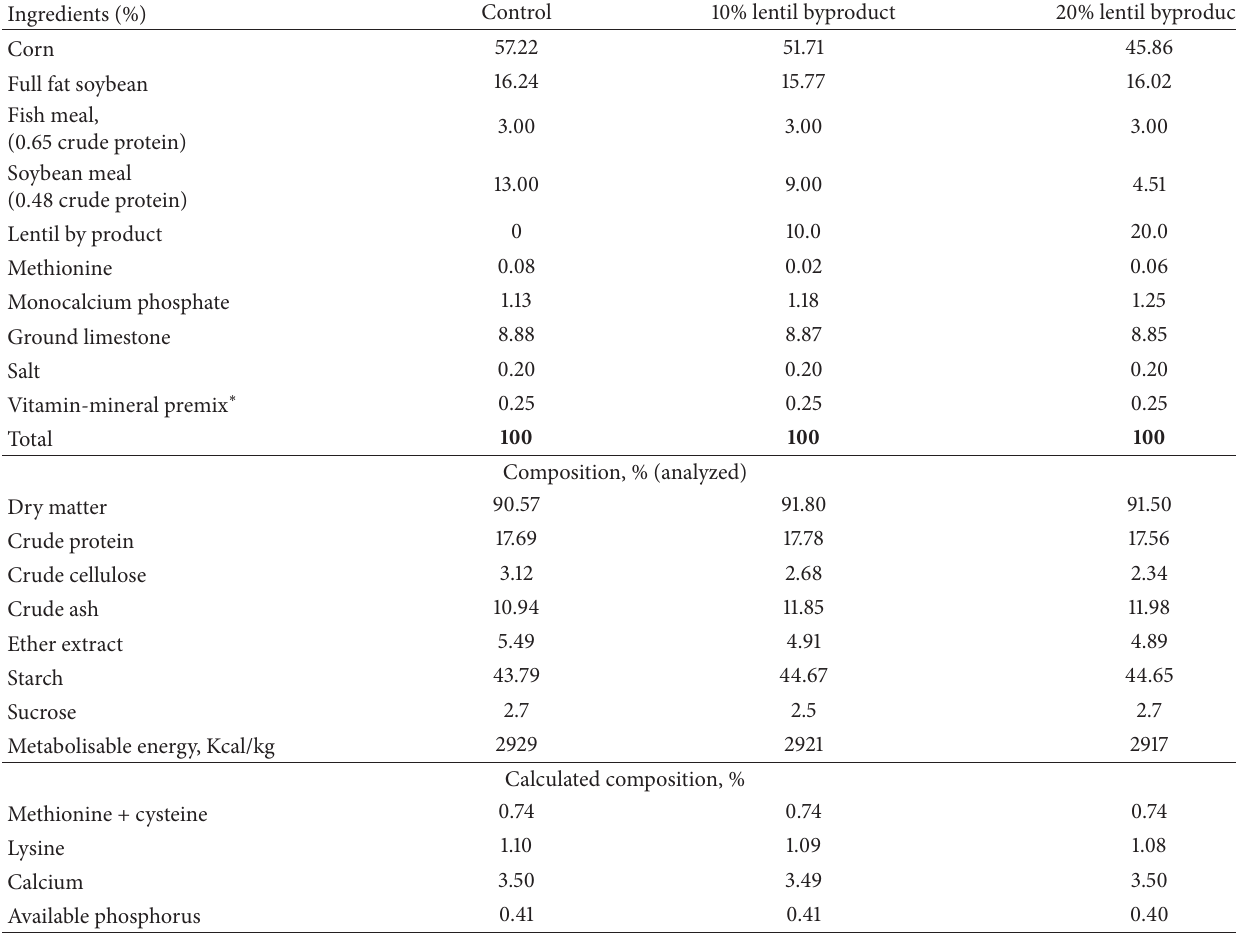
Table 2: Ingredient and chemical composition of diets used in the study (as fed).